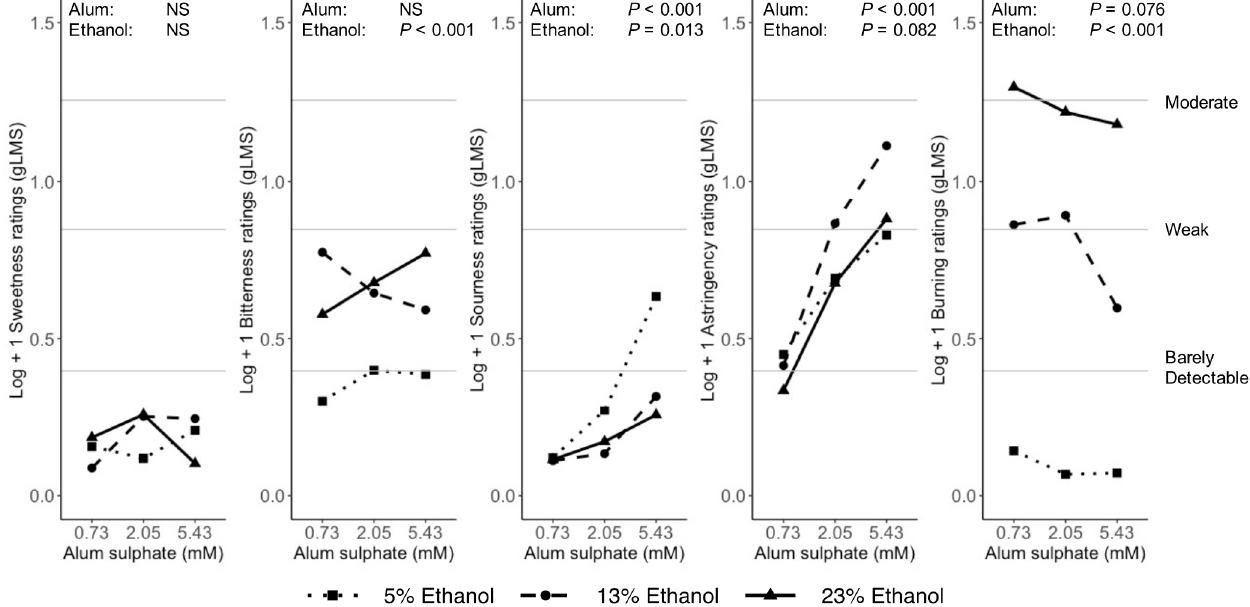
Figure 7. Mean ratings of sweetness, bitterness, sourness, astringency and burning/tingling in the binary solutions of ethanol (5%, 13%, 23% v/v ) and aluminium sulphate (0.73 mM, 2.05 mM, 5.43 mM). Significant differences are indicated from the p -values above each graph (NS = not significant). A full summary of the model including the effect of thermal taste status and 2-way interactions is included in Table S2.